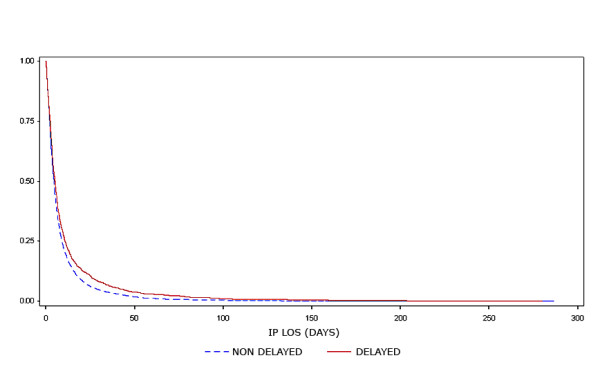
Unadjusted Kaplan-Meier survival curve comparing hospital length of stay of delayed versus non-delayed patients.